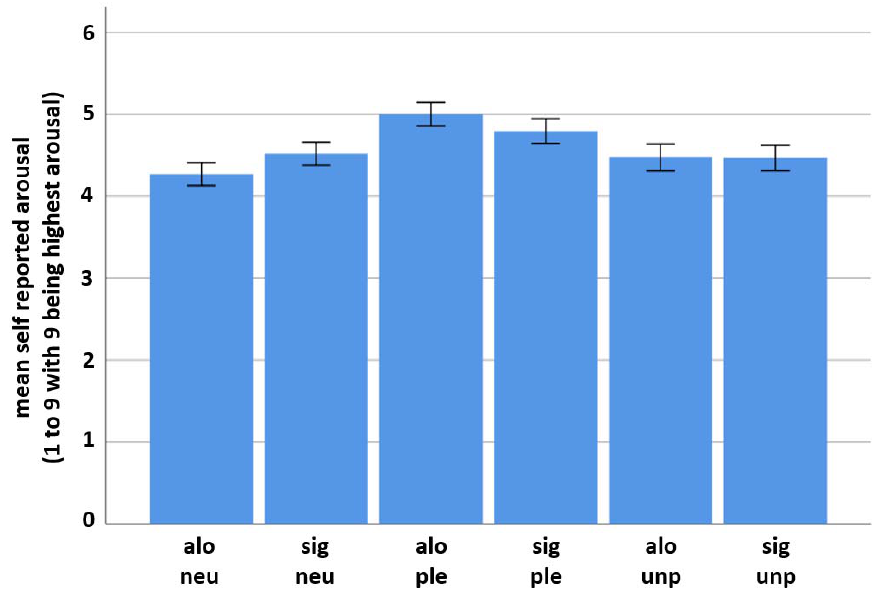
Figure 4. Self-reported arousal values (including standard deviations). Significant differences between both social conditions were found for the neutral and the pleasant, but not for the unpleasant emotion category (see above for t -test results). In the neutral emotion condition, the presence of a significant other person resulted in higher self-reported arousal, whereas in the pleasant emotion condition being alone resulted in higher self-reported arousal. For variable names see Figure 2.